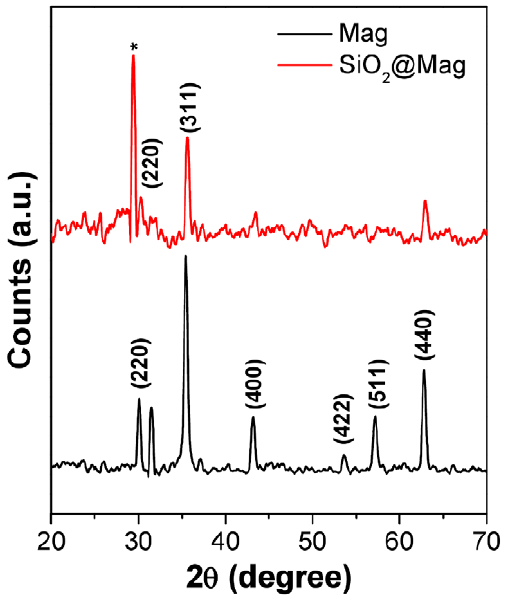
Figure 2. XRD patterns obtained from Mag and Mag@SiO2 nanoparticles. XRD peaks with corresponding Bragg reflections of magnetite have been indicated. (*) corresponds to the XRD peak arising from a mixed Fe-Si phase.